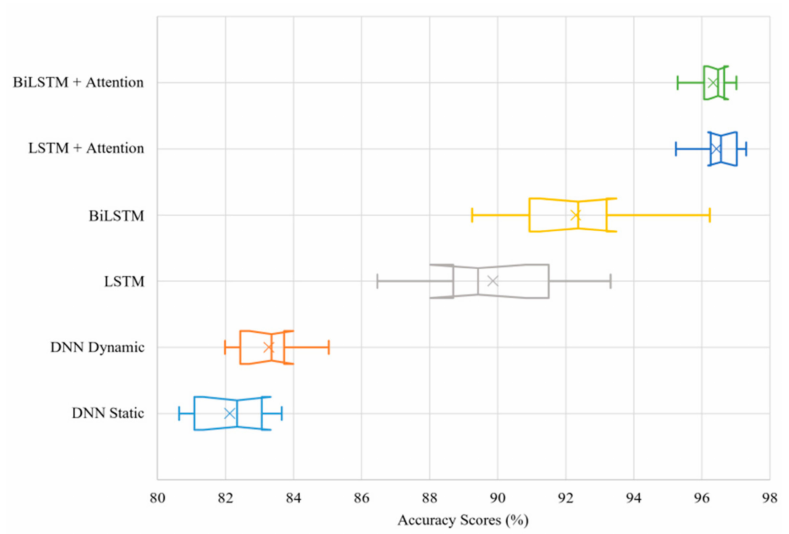
Figure 4. Model accuracy evaluations for ten training and testing runs shown by boxplots and × indicating the mean. Table 4. Average performance scores of the models against test